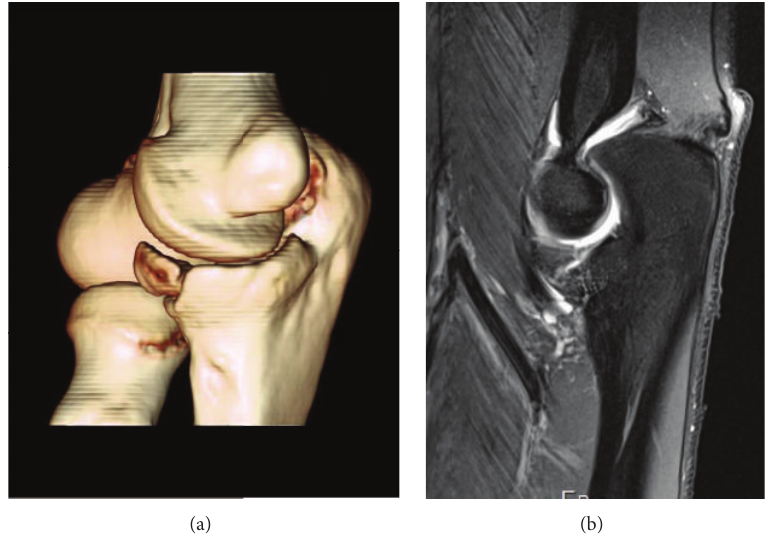
Figure 2: Follow-up imaging studies at 4 and 6 months after diagnosis. (a) Three-dimensional CT-scan reconstruction of coronoid process nonunion: no callus formation and no displacement. (b) Elbow MRI: nonunion and lack of edema or joint effusion.